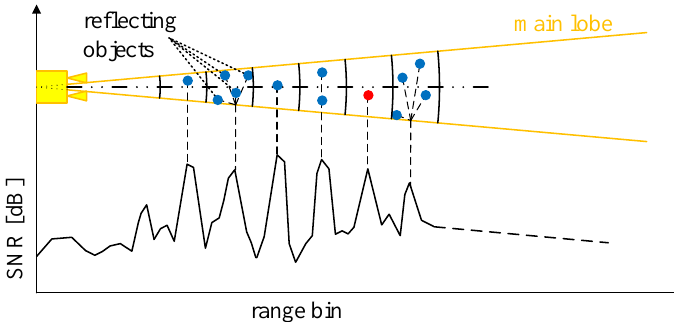
Figure 3. Schematic illustration of the IBIS-S measurement principle in relation to the spatial resolu- tion